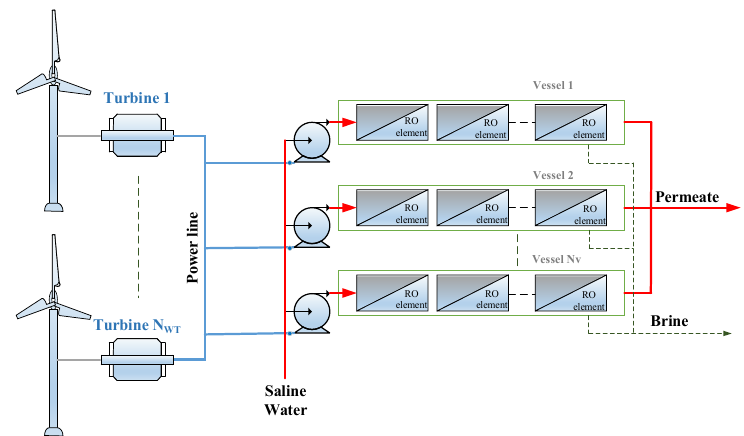
Figure 1. Wind-driven reverse osmosis (RO) plant structure.